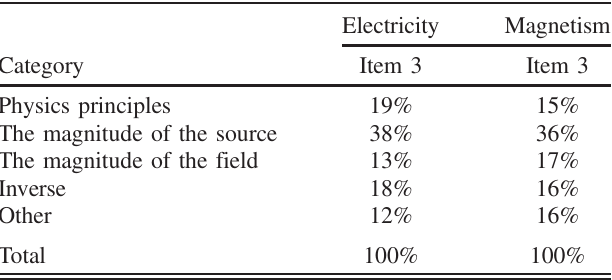
TABLE III. Comparison of the results for item 3 per category in the electricity and the magnetism